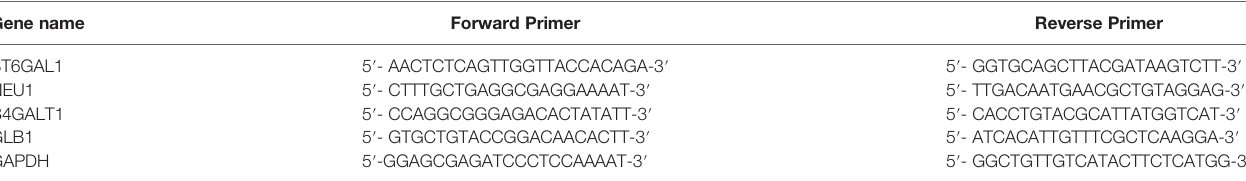
TABLE 2 | Primer sequences for the glycosylation